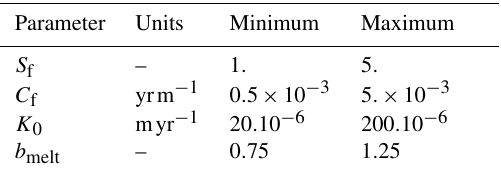
Table 2. Selected parameters included in the Latin hypercube sam- pling (LHS) ensemble with their associated ranges. Parameter Units Minimum